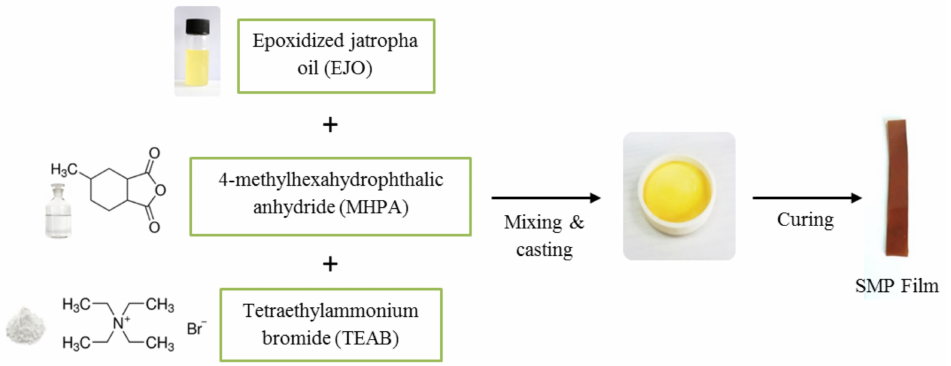
Figure 1. Schematic view of the preparation of jatropha oil-based shape memory polymer